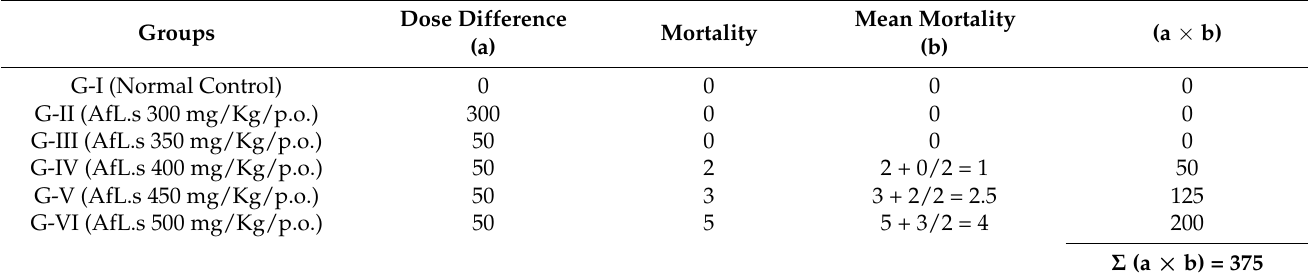
Table 5. Calculation of median lethal dose LD 50 of AfL.s.